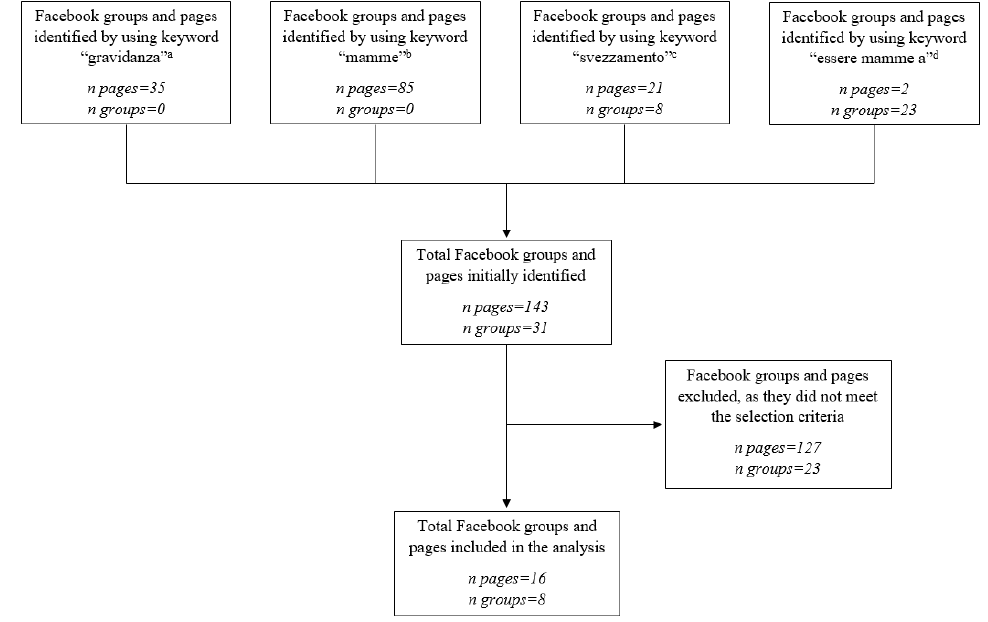
Figure 1. Diagram of groups/pages selection process ( a “Pregnancy” ; b “Mothers” ; c “Weaning” ; d “Be mothers in” ).